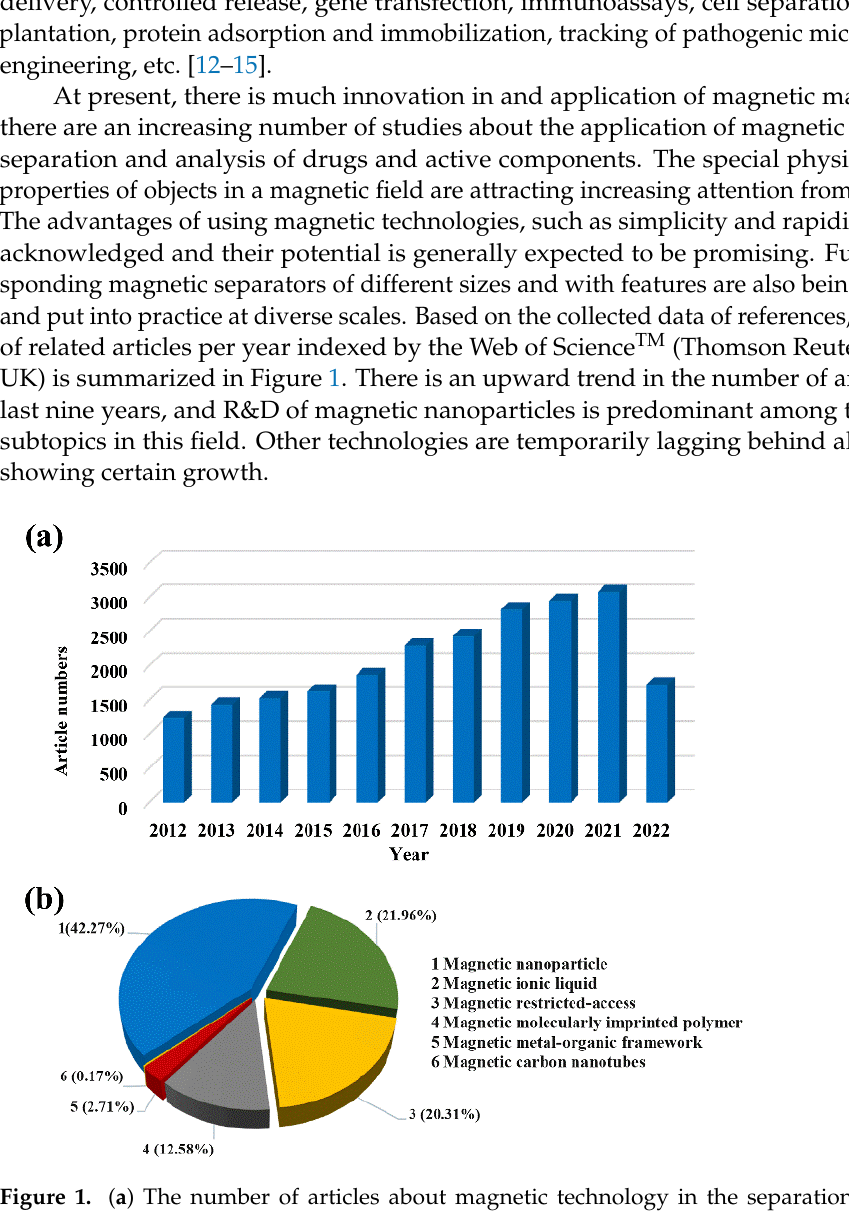
Figure 1. ( a ) The number of articles about magnetic technology in the separation of bioactive molecules and biochemical objects (search keywords: magnetic separate* OR magnetic extract* AND bioactive OR natural* OR medicine); ( b ) the percentage of research articles on different magnetic materials (January 2012~September 2022).